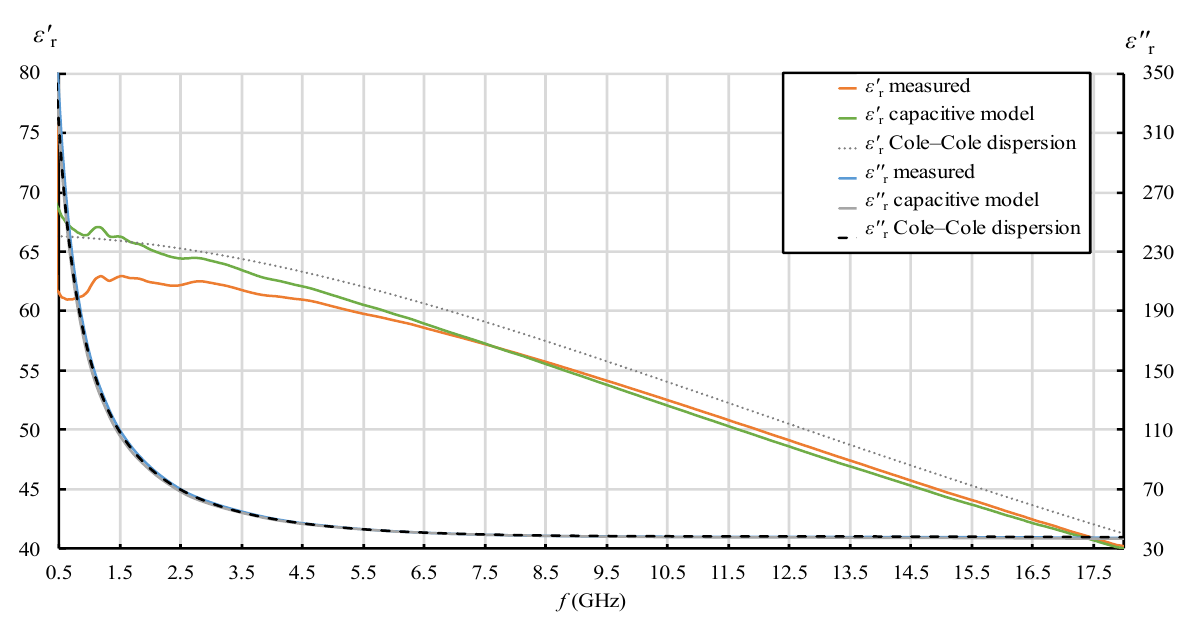
Figure 10. 𝜀 r′ and 𝜀 r″ for 1M saline: measurement result as a final value obtained from the measurement software (“measured”); measurement result obtained by postprocessing the reflection coefficient using the simple capacitive-load model (“capacitive model”) and dispersion model (“Cole–Cole dispersion”).